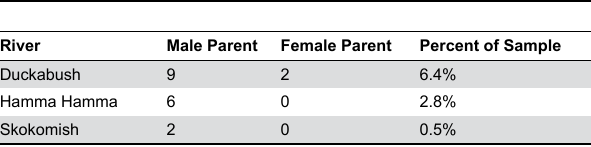
Table 2. The number and percentage of smolts in samples from each river that had a resident O. mykiss parent.